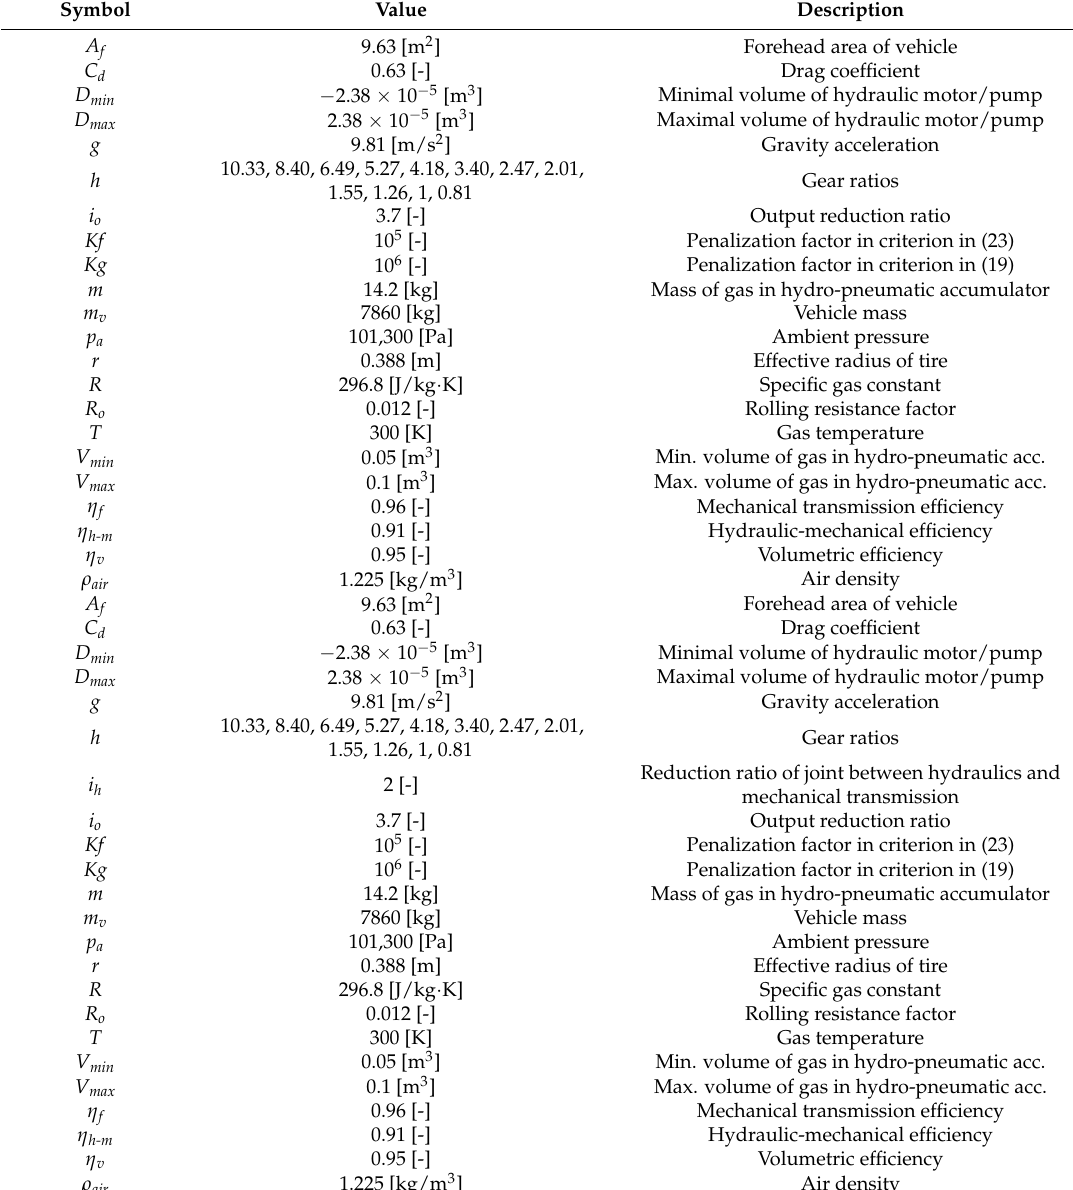
Table A1. List of delivery truck, hydraulics and optimization parameters (from [15,16]).